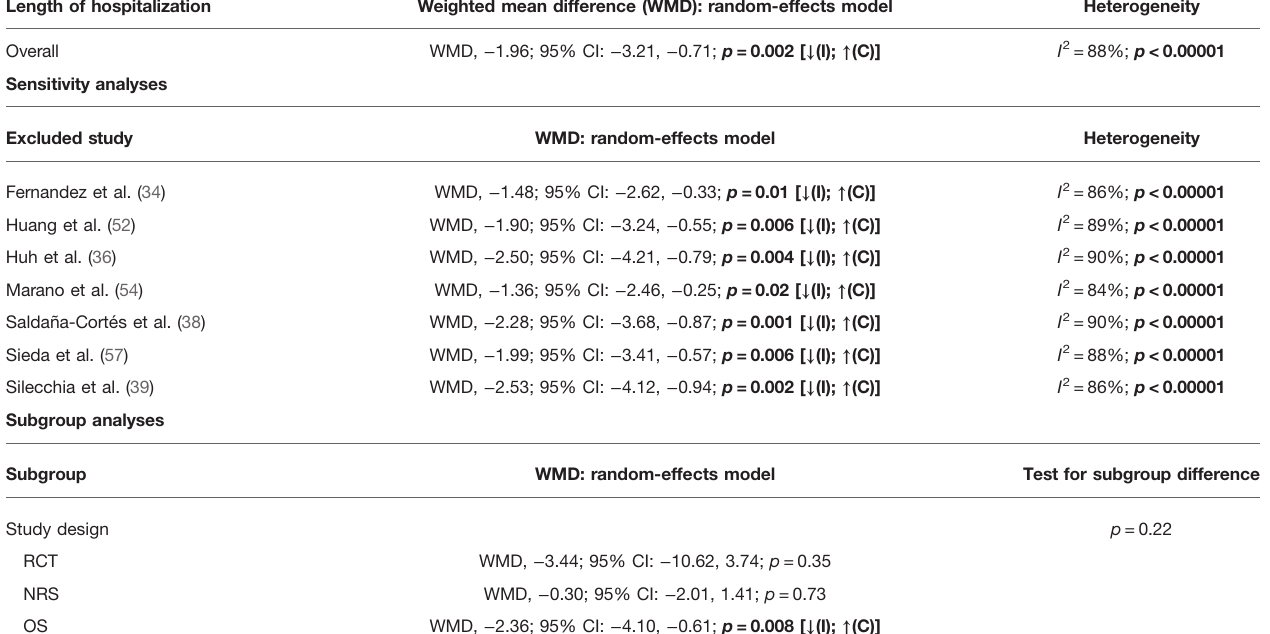
TABLE 7 | Random-effects meta-analysis for the length of hospitalization in the intervention and control